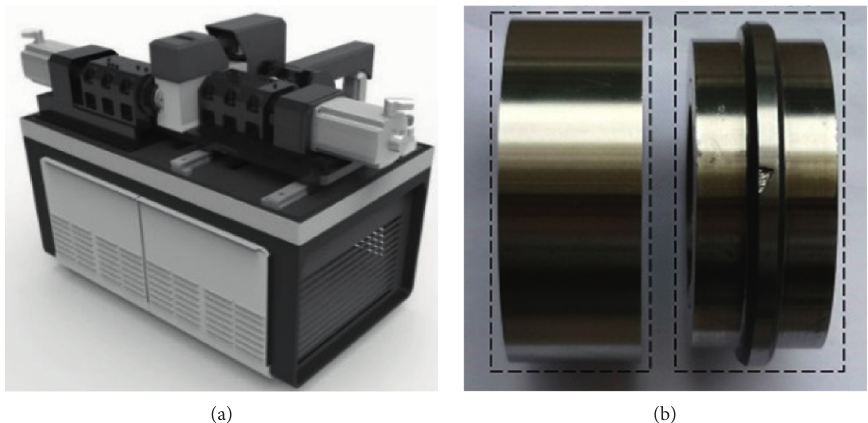
Figure 1: Test equipment and samples. (a) Contact fatigue testing machine and (b) main specimen and companion